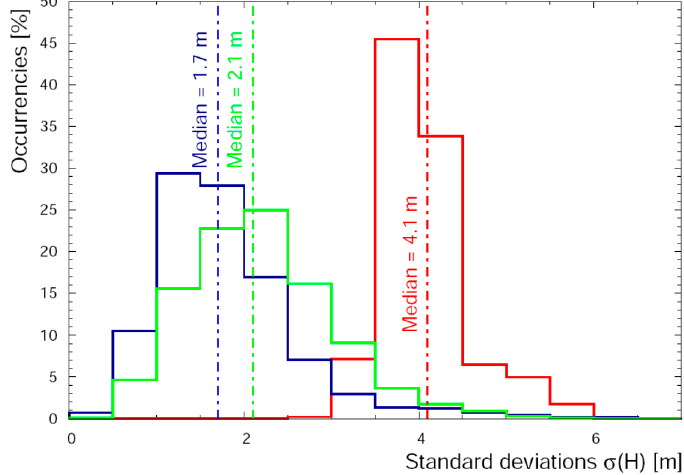
Figure 11. Distribution of σ (H) (standard deviations of heights) in the range (35–66) m (red solid line), (79–340) m (blue solid line) and (340–2194) m (green solid line) measured at 1 Hz.